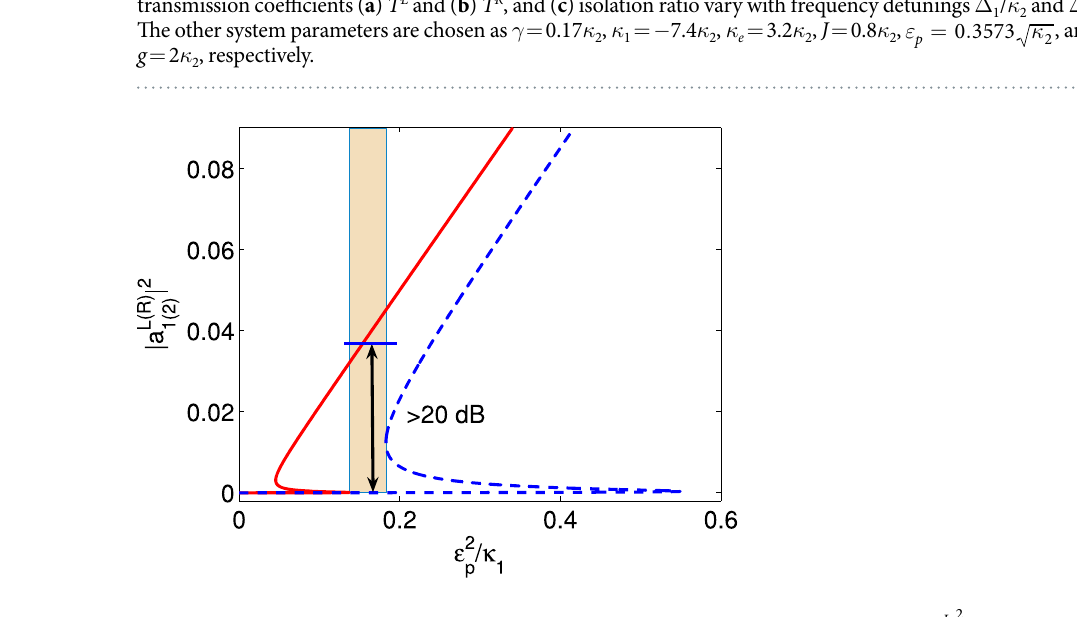
Figure 5. The dependence of the output field on the input field for exchange-directions. a L 2 and a R (red solid line) vary with the input field ε κ / 2 g = 2 κ 1 , κ 2 = − 9 κ 1 , κ e = 4 κ 1 , and J = 1.25 κ 1